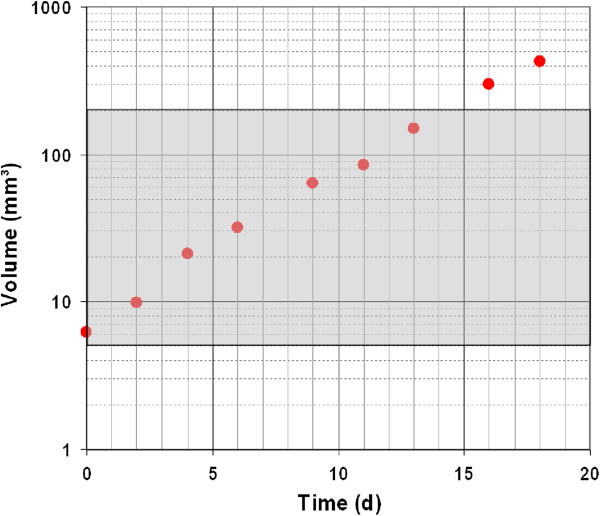
Exponential tumour growing of KHT mouse sarcoma. Exemplary growth curve of one KHT mouse sarcoma after injection of 500 KHT cells between the cartilage and the skin of the right mouse ear. The volume increase is shown in dependence on time starting at the tumour size at start of treatment; exponential growing is indicated for tumour volumes between 5 and 200 mm3 (grey coloured area).